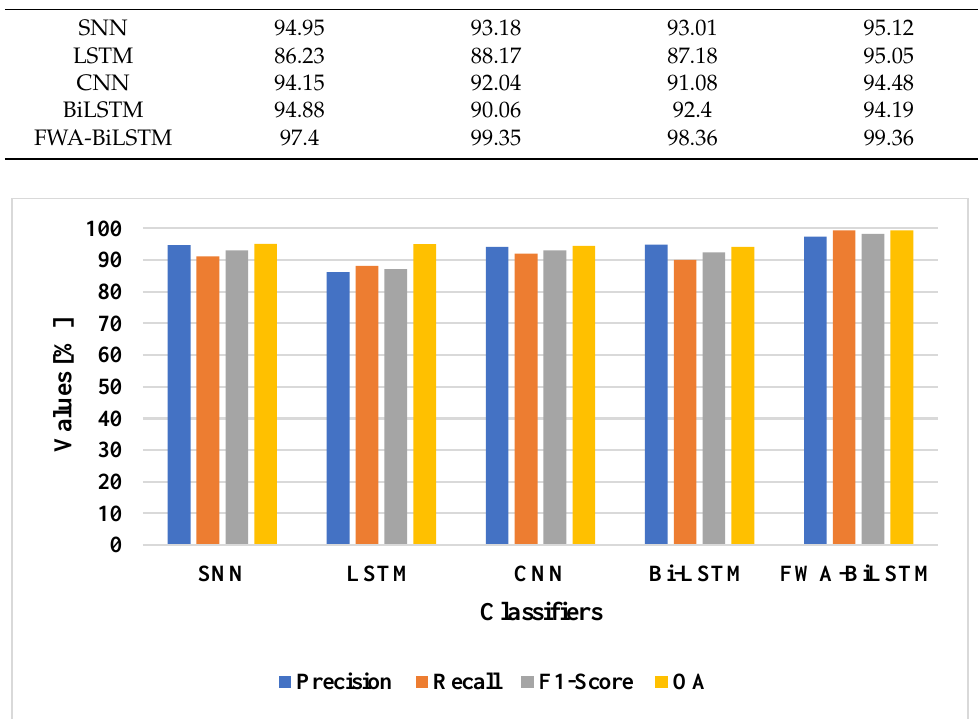
Figure 10. Classifier with attention layer on SVD dataset.